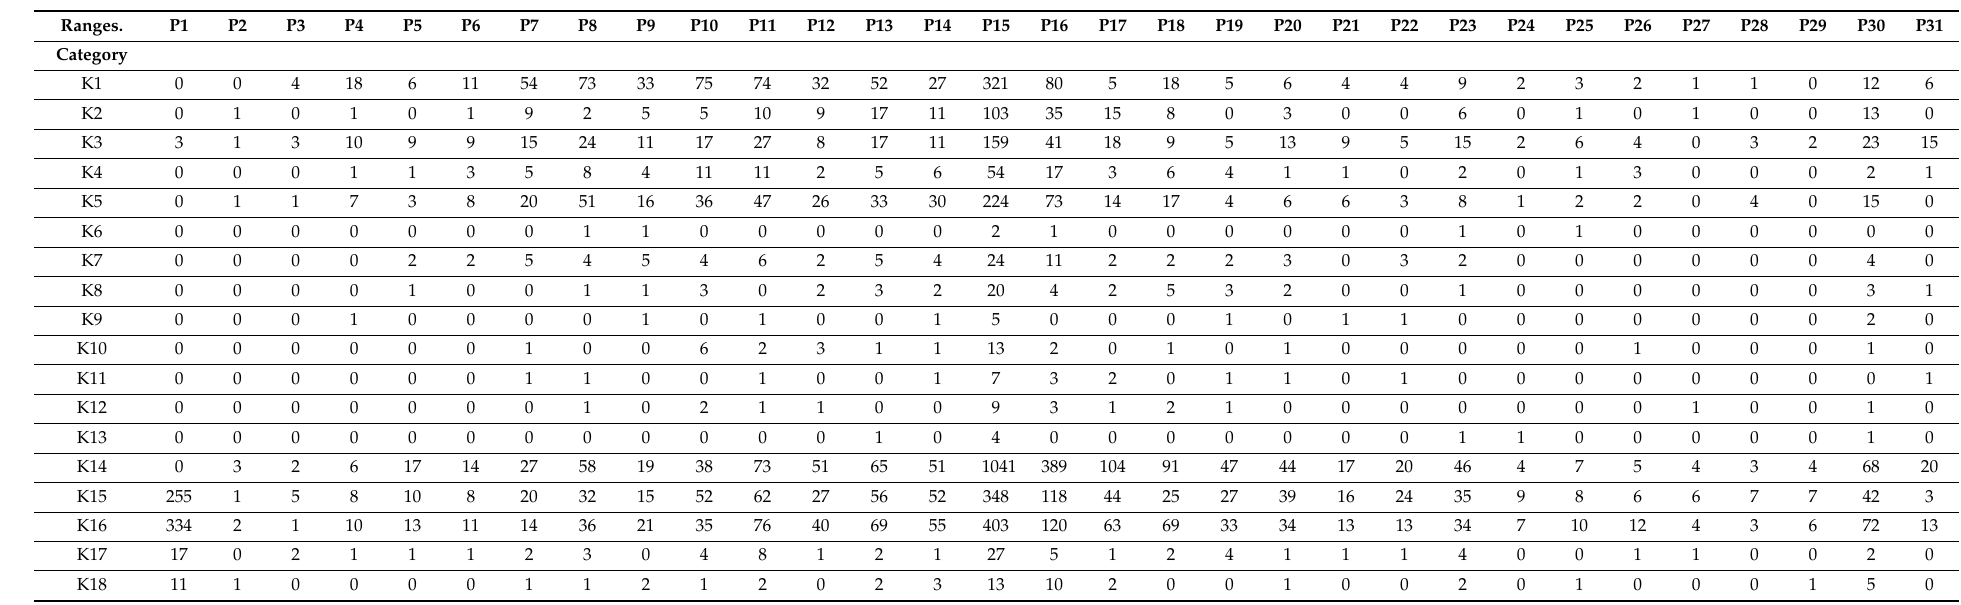
Table 6. Numerical input data in terms of campaign duration